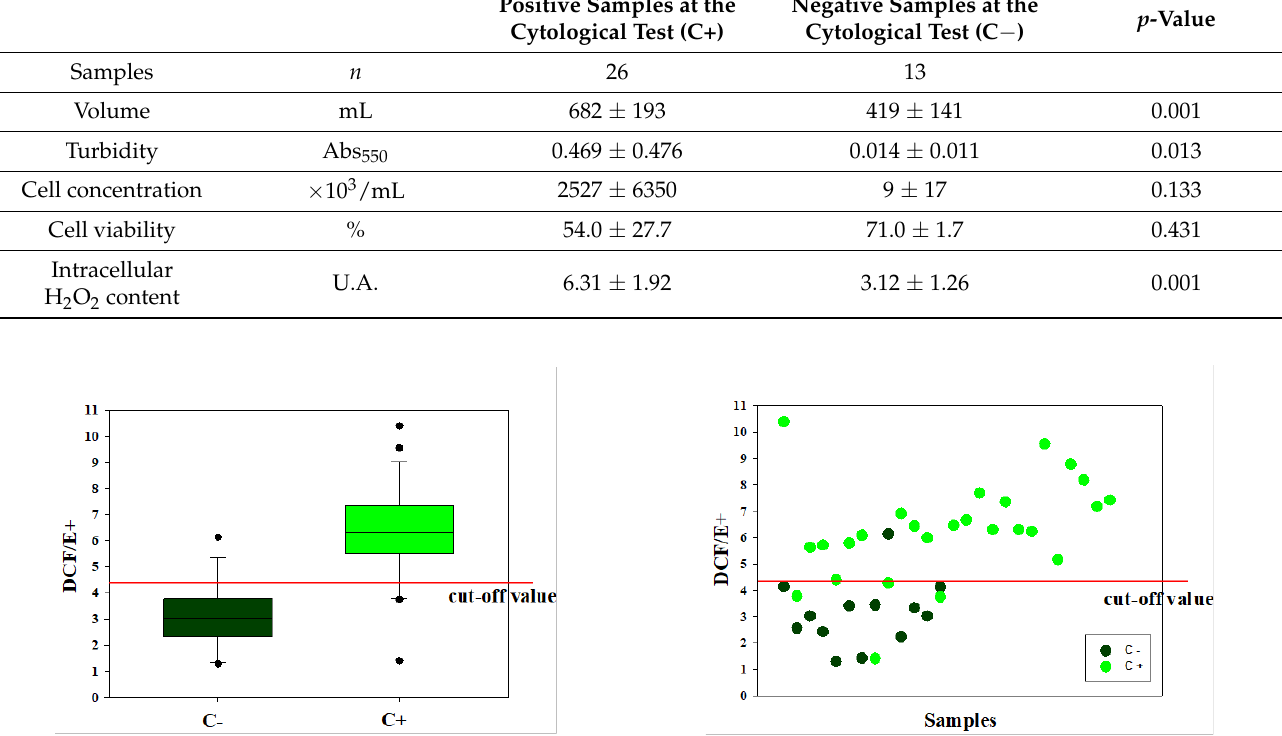
Figure 4. Normalized fluorescence intensity in relation to cell content (DCF/E+) in positive (C+) and negative (C − ) cell specimens at the stained smear cytology assay. On the left, values of the medians with error bars at the 10th, 25th, 75th, and 90th percentiles and cut-off value. On the right, the distribution of values in relation to a cut-off value obtained from the mean + SD of the C − group. The microbiological examination showed a positivity for Escherichia coli in